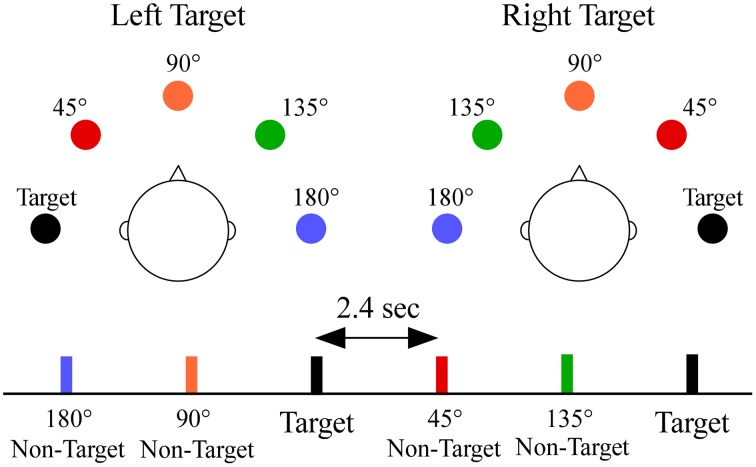
Overhead schematic of the virtual sound locations. The sound locations are shown relative to the listener's head for each target location, and are color-coded to a segment of a stimulus sequence. Subjects were required to respond by button press only to sounds appearing at one target location [−90° (left) or +90° (right)] within a block. Non-targets were classified by their angular distance from the target location (termed angular disparity). Sounds at each location were equally probable and randomly presented with a constant stimulus onset asynchrony of 2.4 s.